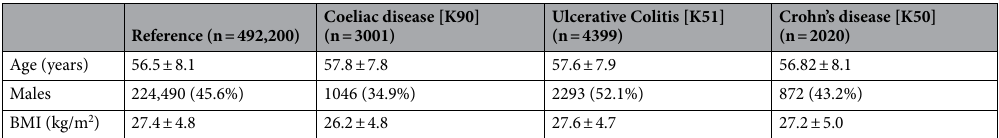
Table 1. Baseline characteristics of the study population. The reference group consists of individuals without Crohn´s disease, ulcerative colitis, or coeliac disease. BMI body mass index.